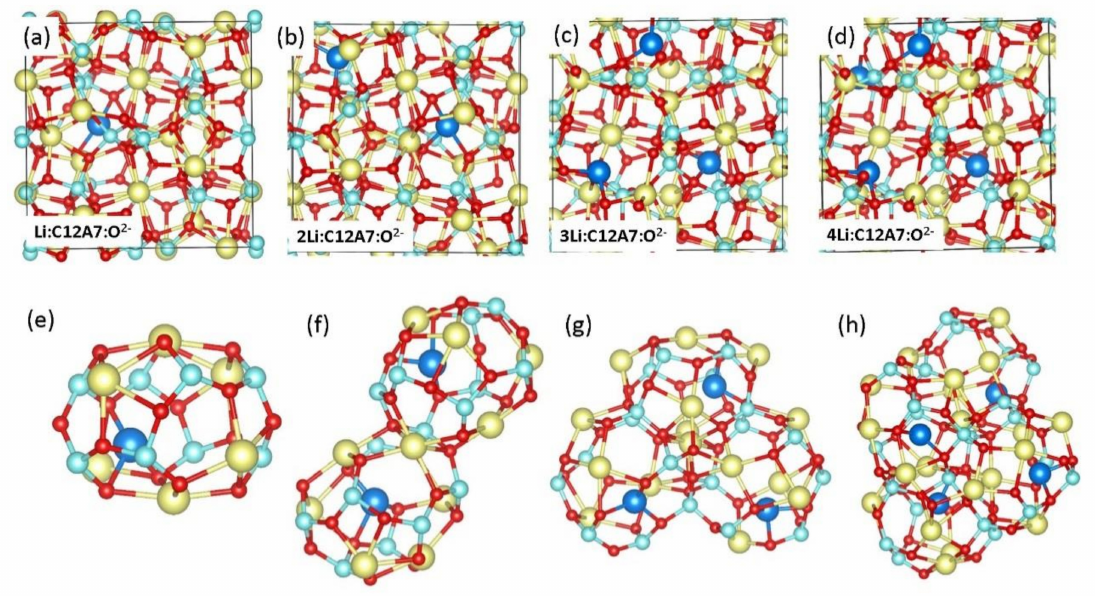
Figure 2. ( a – d ) Relaxed structures of Li:C12A7:O 2 − , 2Li:C12A7:O 2 − , 3Li:C12A7:O 2 − and 4Li:C12A7:O 2 −